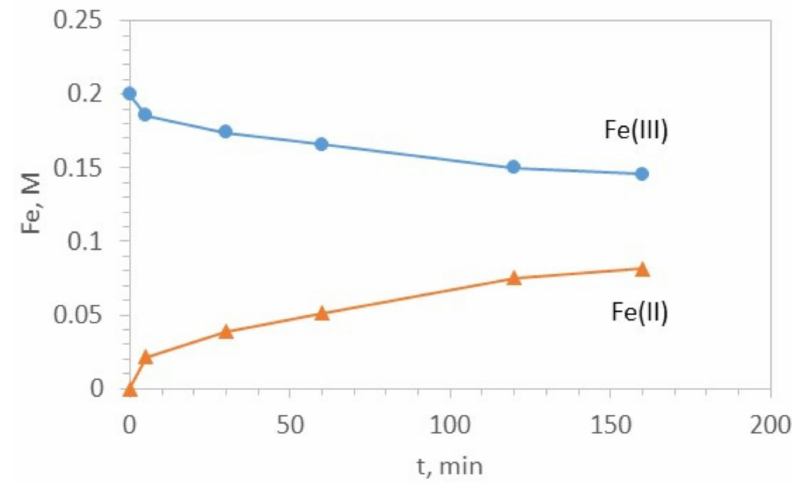
Figure 1. Kinetics of Fe(III) reduction with Fe(0). Initial solution: 0.2 M FeCl 3 and 1.4 M HCl. Fe(0) dose 1.75